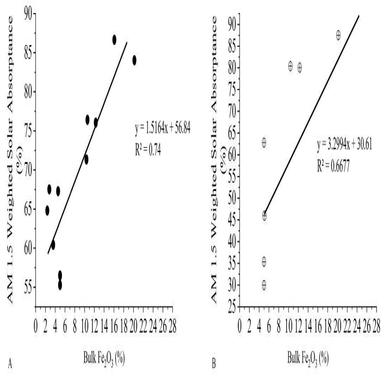
Relationship between bulk iron oxide content and solar absorptance in the as-received samples (A) and the thermally cycled samples (B).